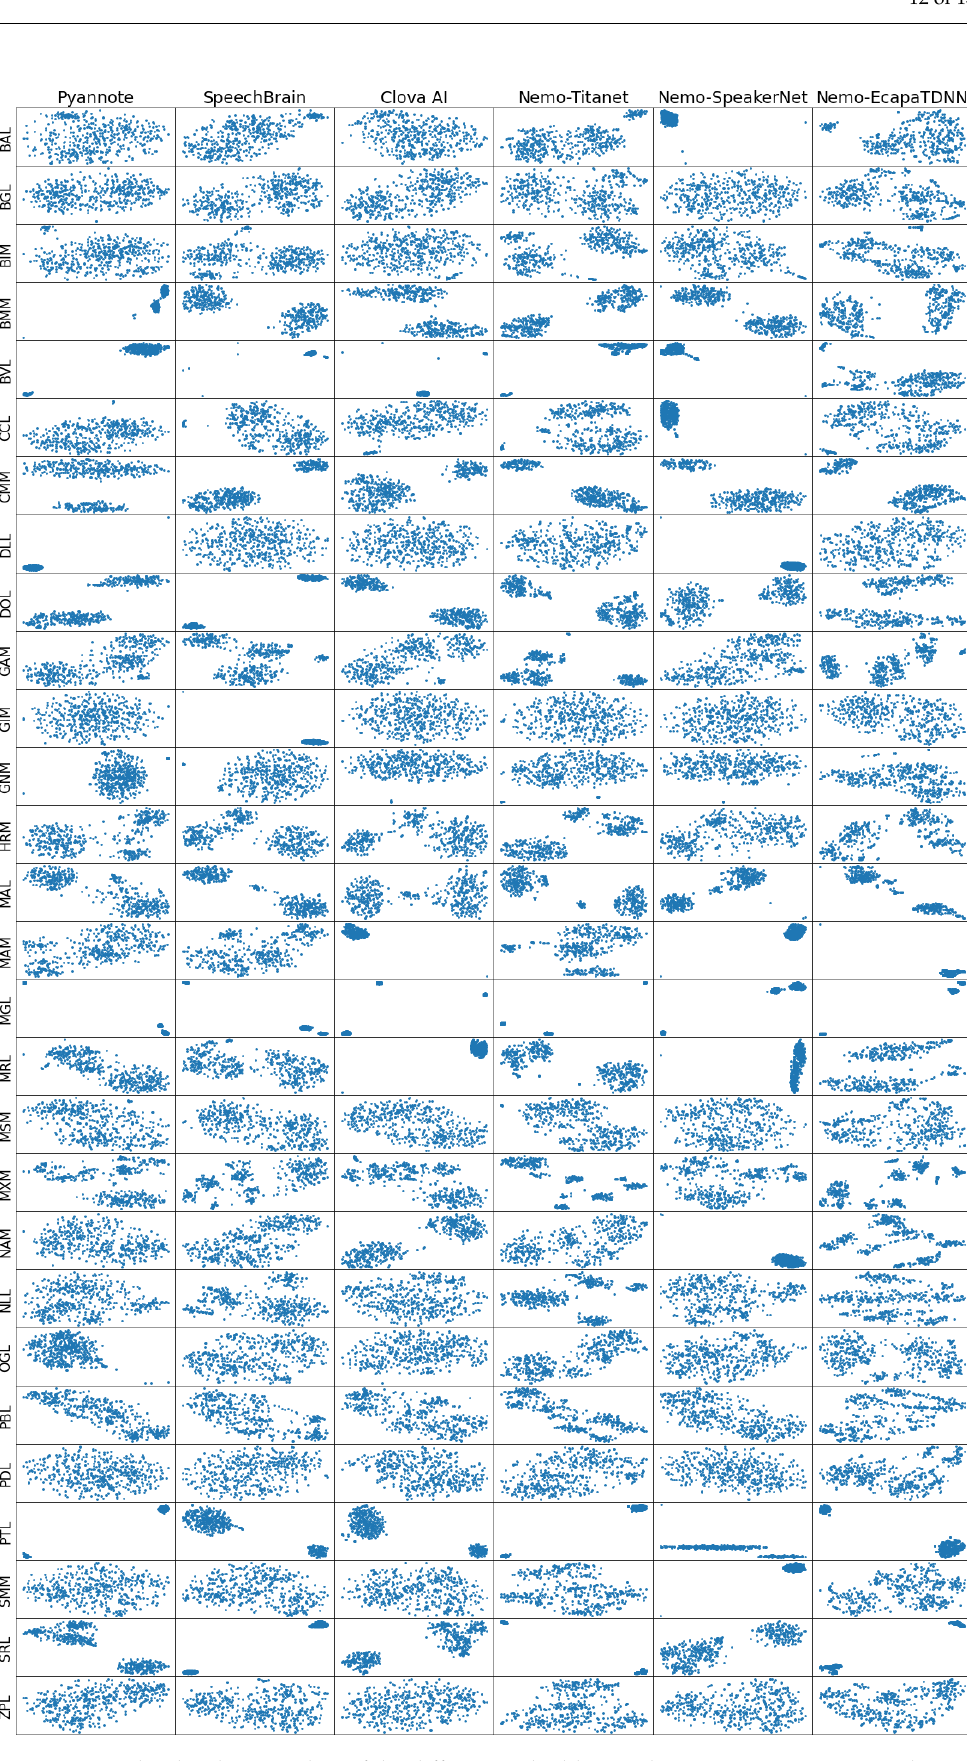
Figure 6. Speaker-level t-SNE plots of the different embedding architectures— SWARA2.0